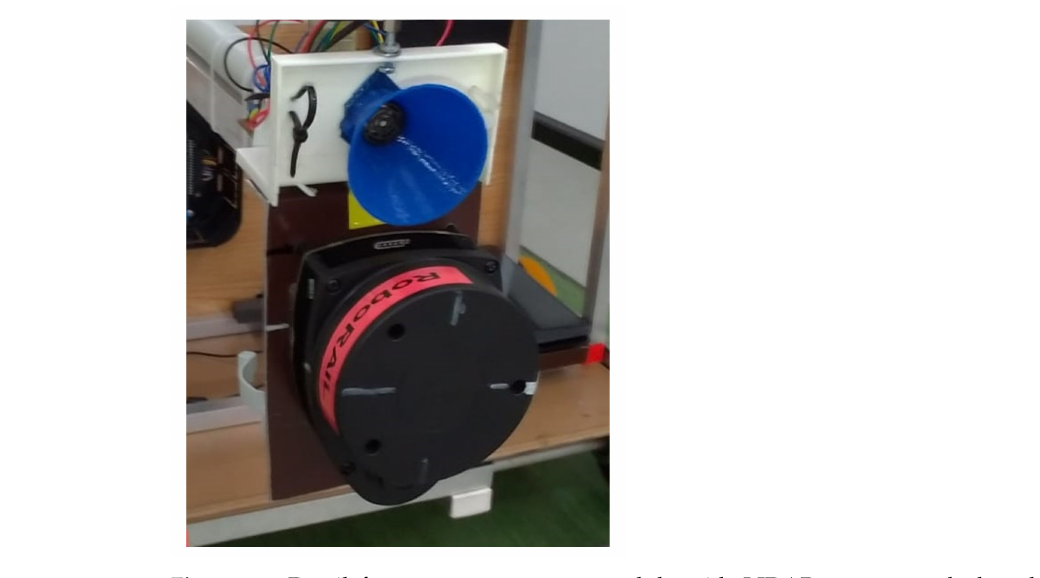
Figure 6. Detail for gauge assessment module with LIDAR scanner and obstacle detection module (ultrasonic).